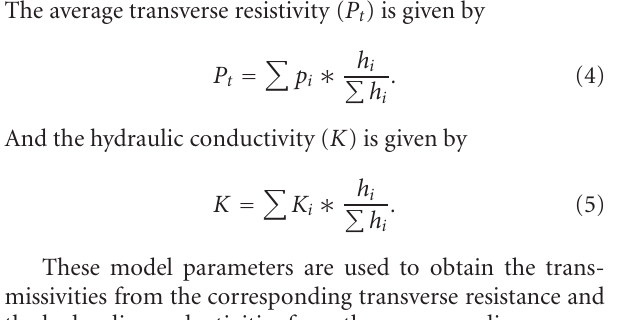
Depth to water ranges Transmissivity T Hydraulic conductivity (m) (m 2 /day) K